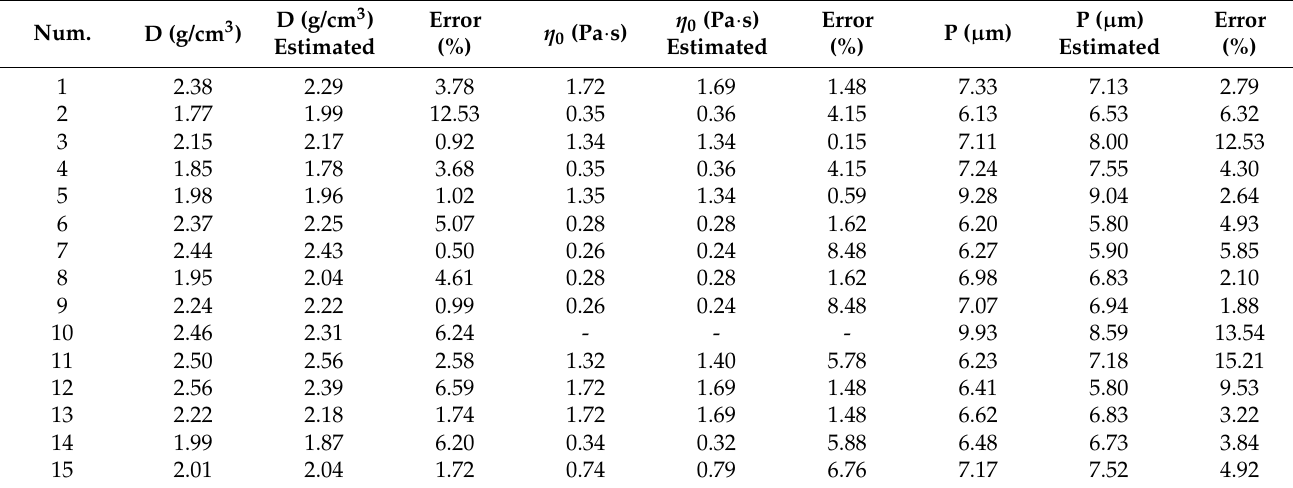
Table 3. Statistical parameters values of polynomial models found for the processing of Ti porous structures.